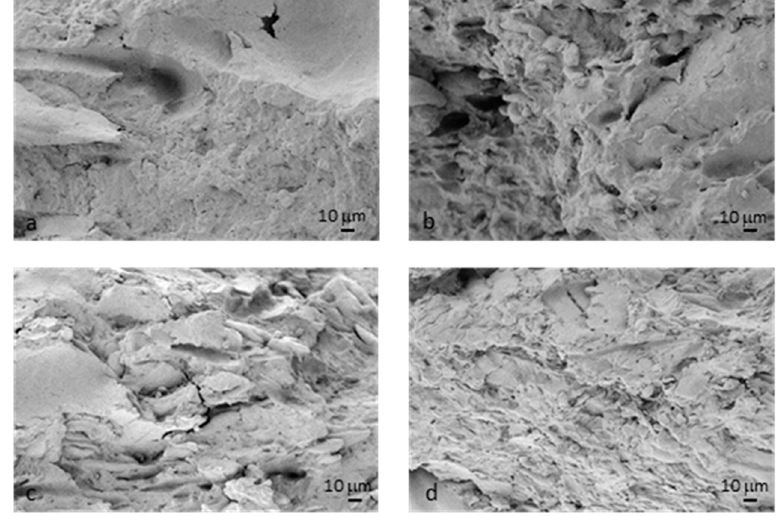
Figure 3 . FESEM images of fractured cross-sections of ( a ) TPF0, ( b ) TPF1, ( c ) TPF2 and ( d ) TPF3 films, acquired at 1000× magnification.